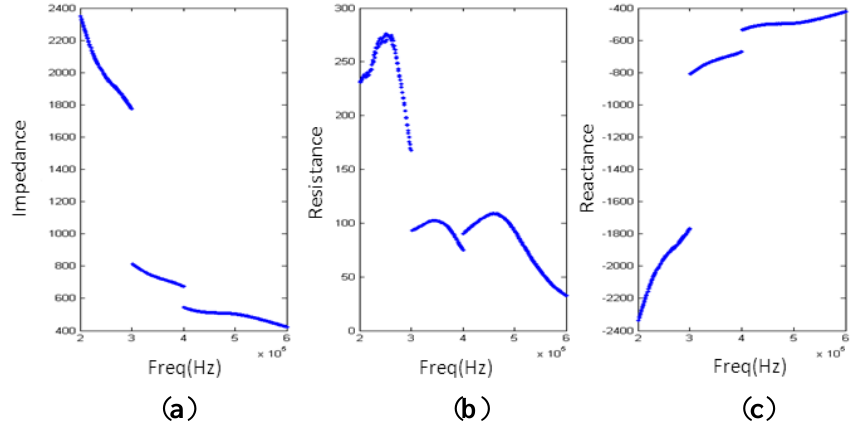
Figure 8. Results of impedance measurement: ( a ) impedance; ( b ) resistance; ( c ) reactance.